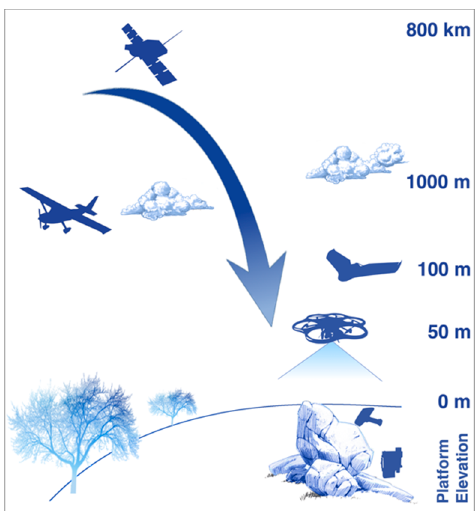
Figure 2. The approach taken to improve mineral exploration. Entailing the use of remote sensing platforms; from satellite-, to airborne-, to Remotely Piloted Aircraft System (RPAS)-based data acquisition, as well as field validation with remote sensing and geochemical measurements.